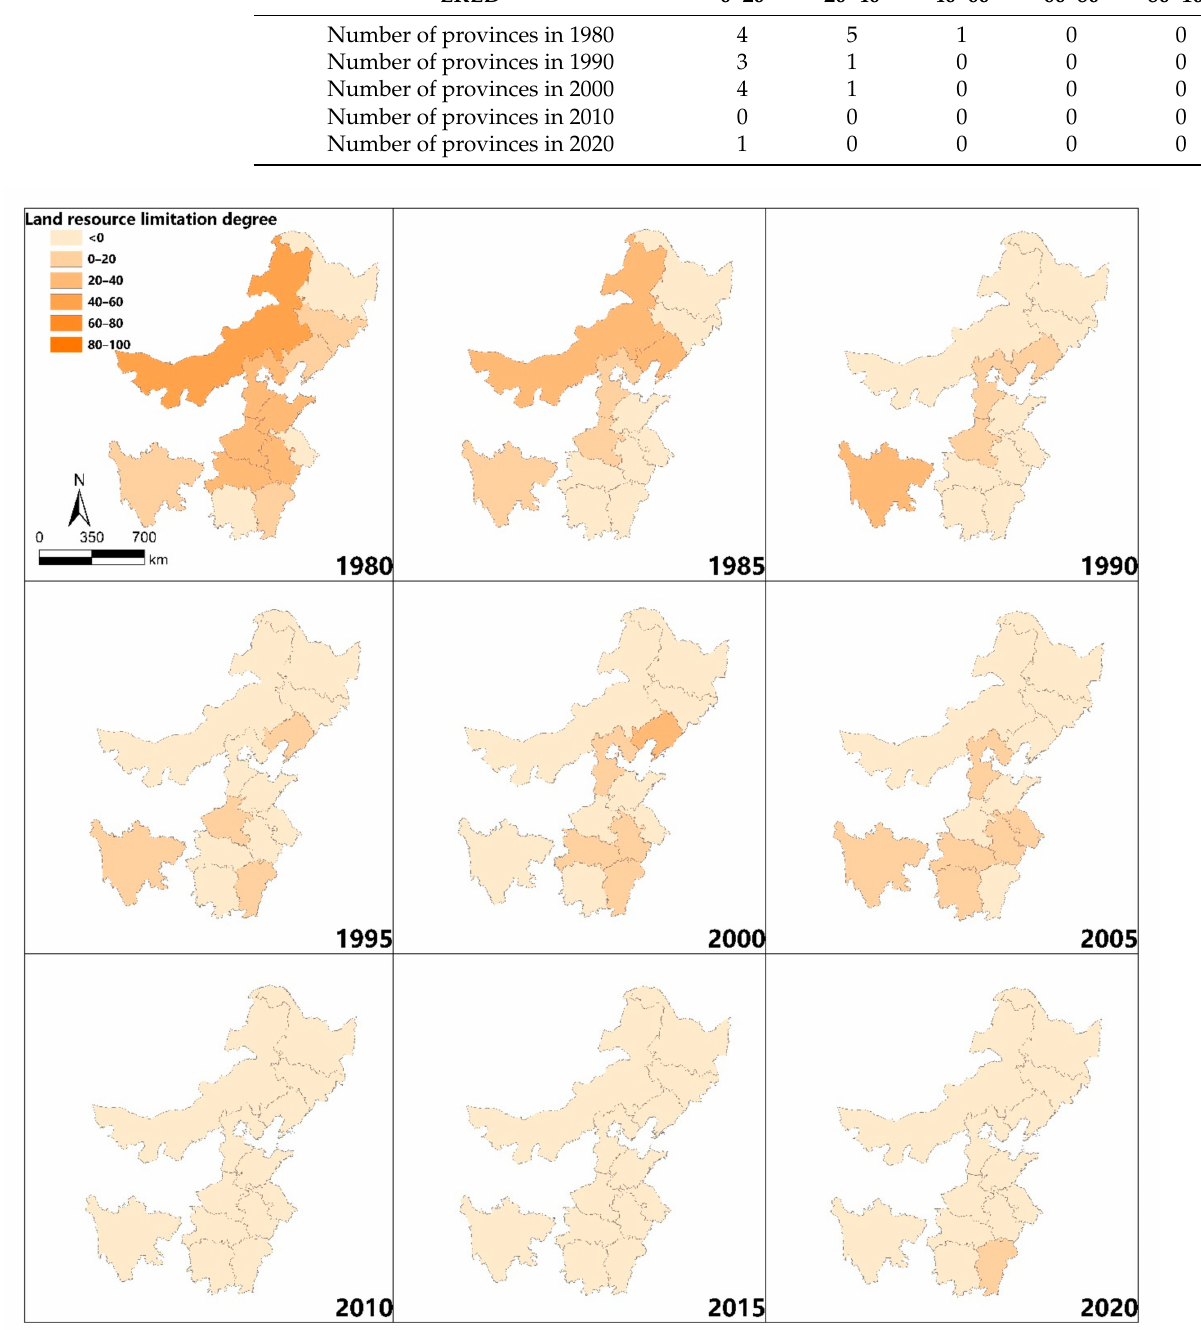
Figure 5. Spatial pattern of the LRLD of China’s major grain-producing